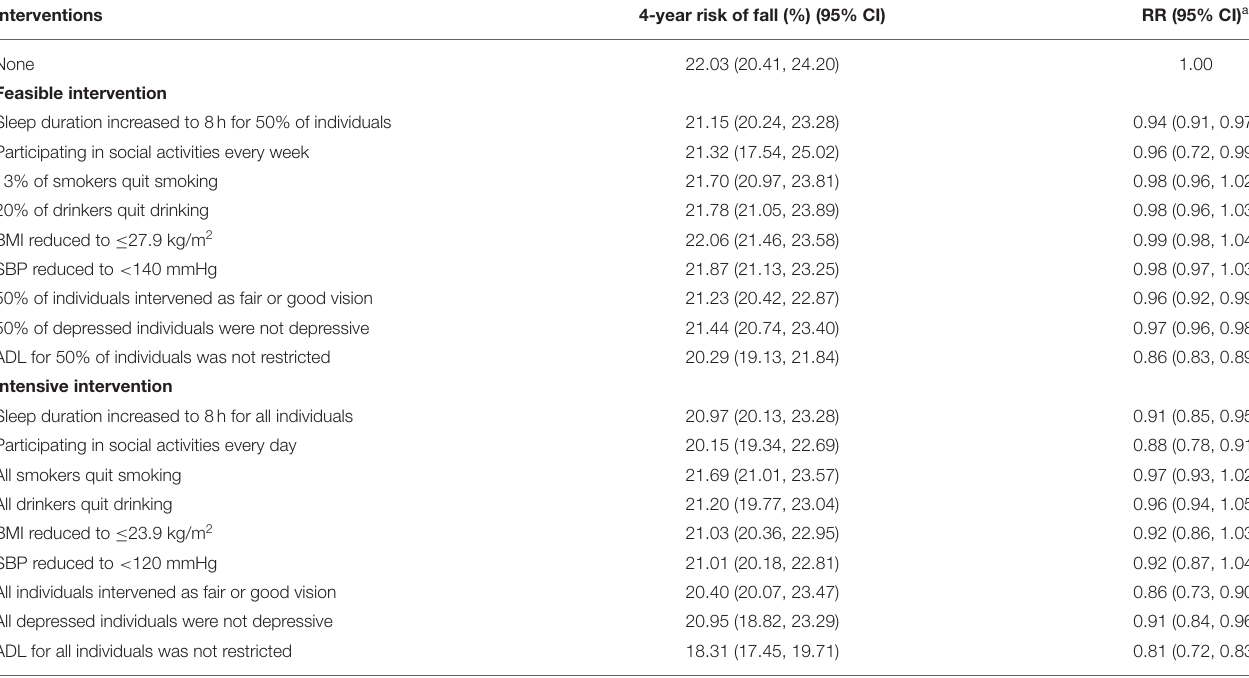
TABLE 8 | Sensitivity analyses for risks of falls by changing the order of time-varying covariates under interventions.